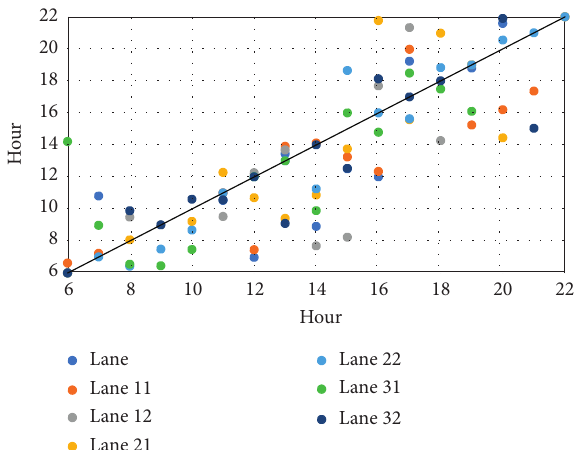
Figure 6: Head vehicle average travel time vs. average link travel time.